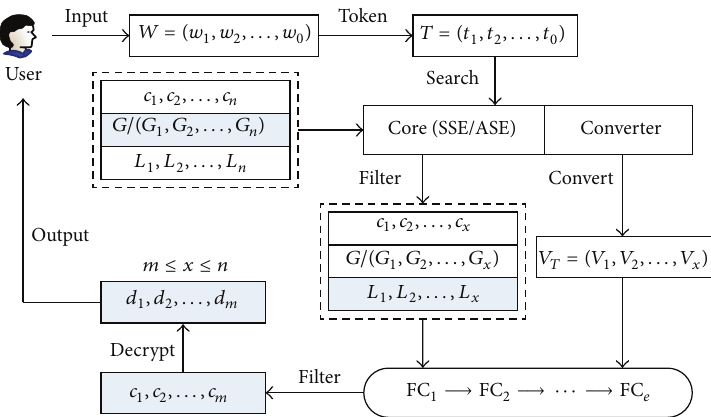
Figure 2: Search process of layered searchable encryption scheme.